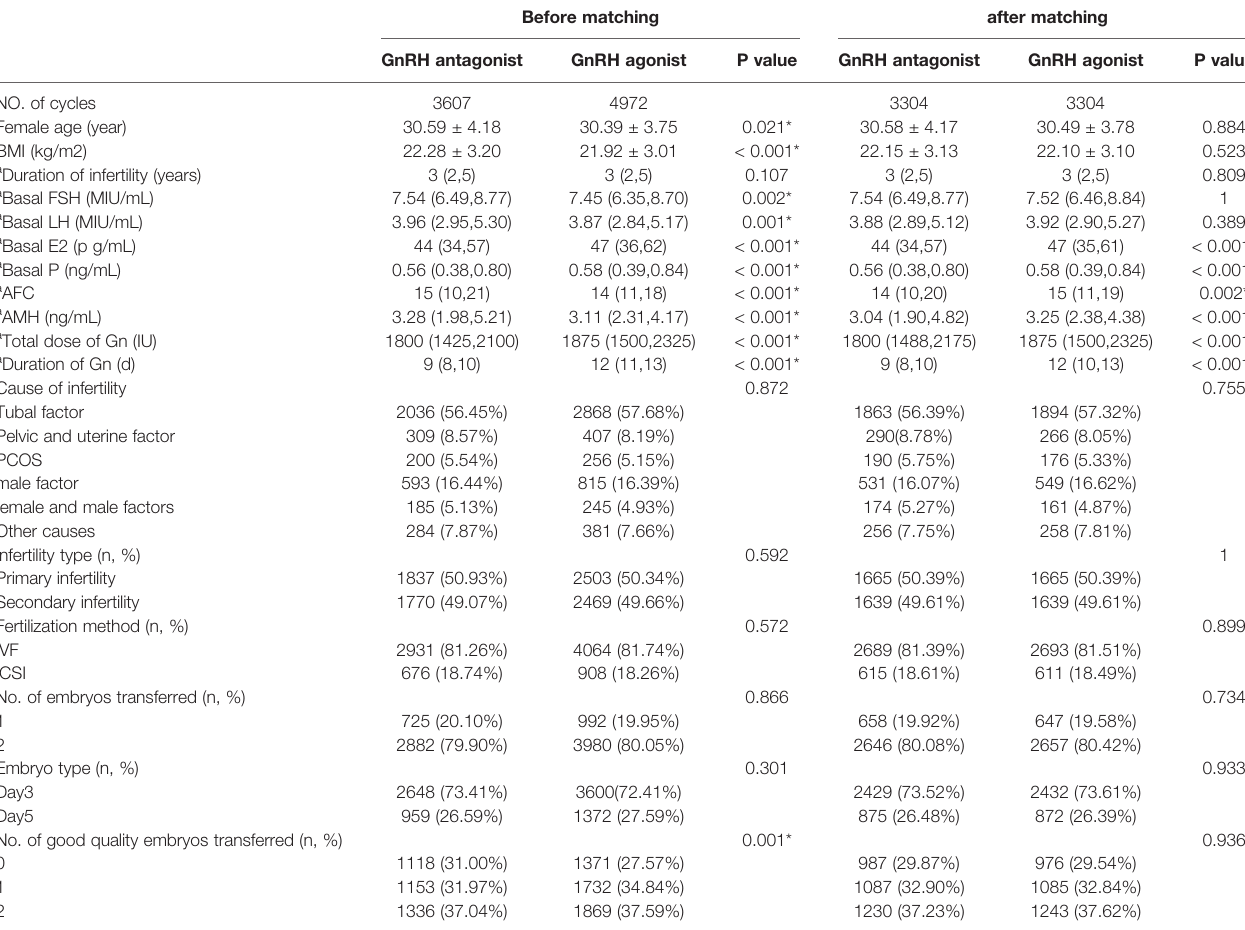
TABLE 1 | Comparison of baseline parameters between the GnRH agonist long-acting protocol and GnRH antagonist protocol and after PS matching. Before matching after matching GnRH antagonist GnRH agonist P value GnRH antagonist GnRH agonist P value NO. of cycles